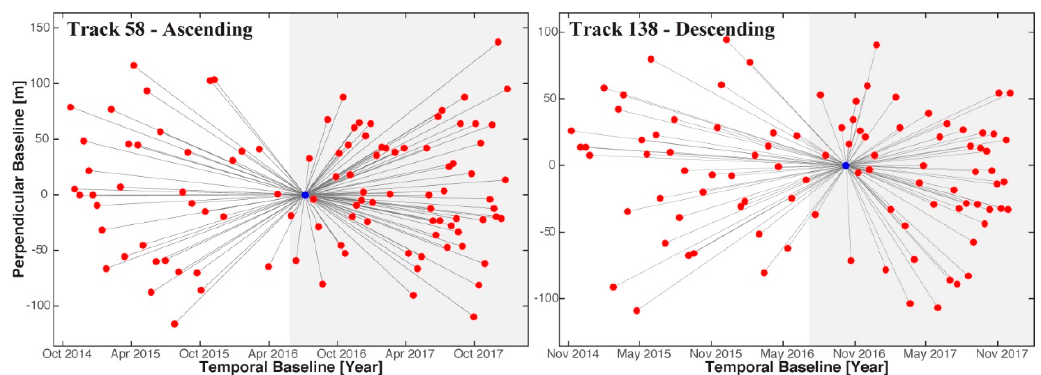
Figure 3. Baseline versus time plots for Sentinel-1 ascending tracks 58 and descending track 138 used in this study, with red dots at the time of image acquisitions. Blue dots indicate the master image used as a reference for each track. Gray lines connect pairs (single master interferograms). Temporal resolution of the dataset increased from 12 days until mid-2016 to 6 days (grey zone) after it, after the launch and starting of operational phase of Sentinel 1B.